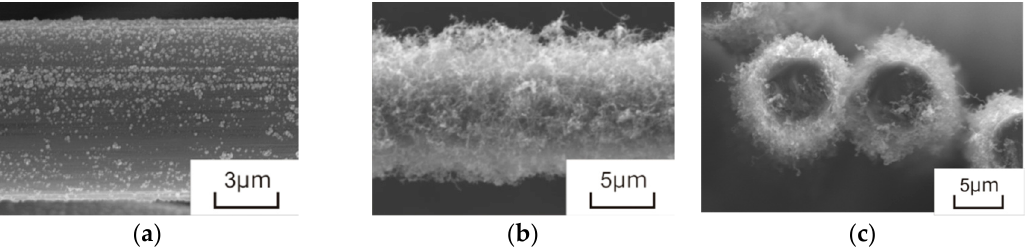
Figure 5. Scanning electron microscope (SEM) images of carbon fibers: ( a ) Dry-Ni–CF; ( b ) Dry-CNT– CF, ( c ) cross section of Dry-CNT–CF.